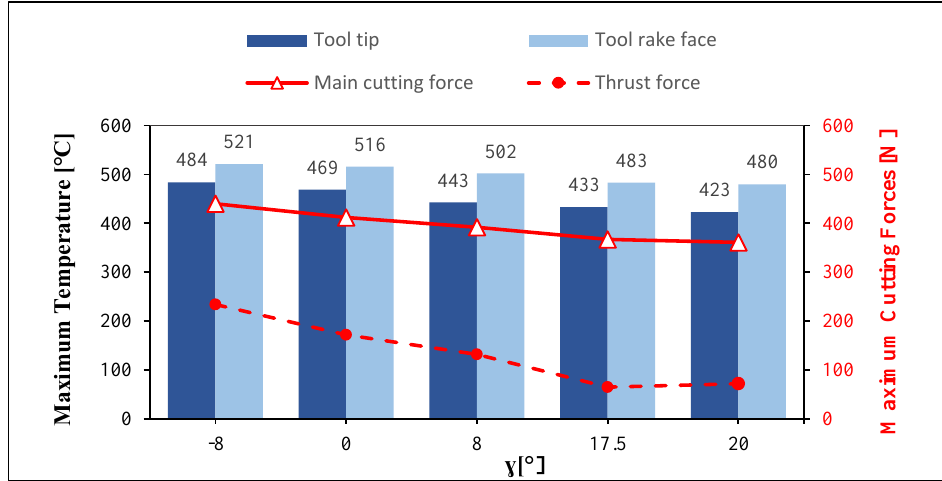
Figure 12. The distribution of cutting temperature in the machined surface for the rake angles (α = 7° and 𝑟 𝜀 = 20 µm): ( a ) −8°, ( b ) 0°, ( c ) +8°, and ( d ) 20°.